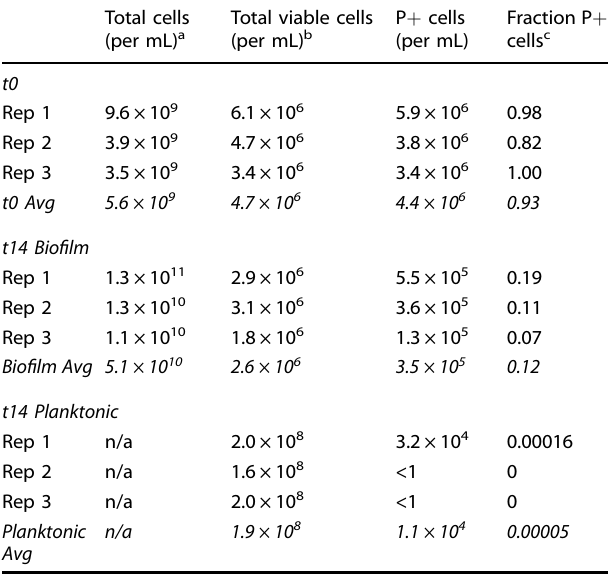
Table 1. Cell counts, as well as absolute counts and fractions of plasmid-containing (P + ) cells for each replicate bio fi lm or planktonic population of the Tet −